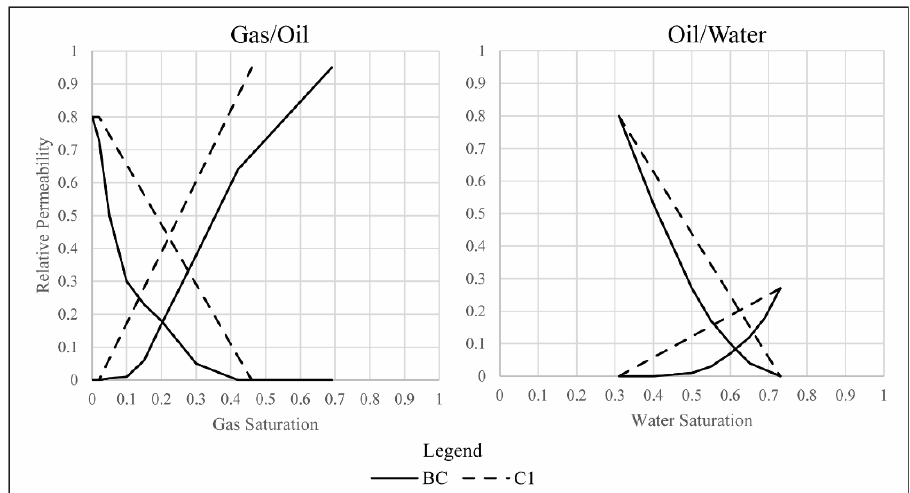
Figure 2. Plot shows the Base Case relative permeability curve from a UNOCAL study (solid lines) and the C1 relative permeability curve that represents the most linear curve used in the study.